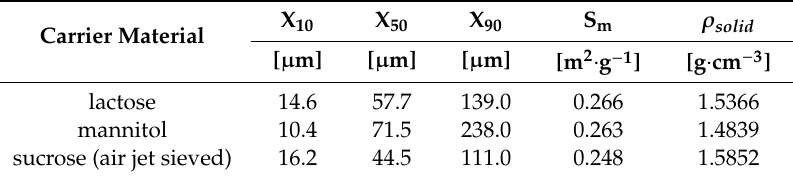
Table 1. Characteristics of particle size distributions and specific surface areas S m (both derived from laser di ff raction measurements), as well as solid densities ρ solid (determined by gas pycnometry) of carrier materials used for fluidized bed